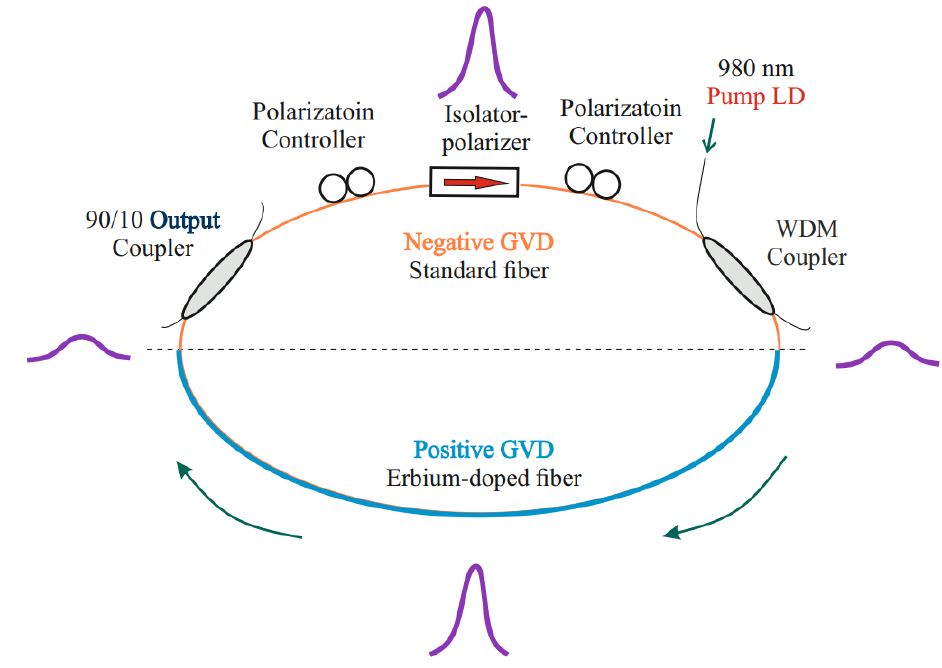
Figure 6. Diagram of an all-fiber laser operating in stretched pulses generation.